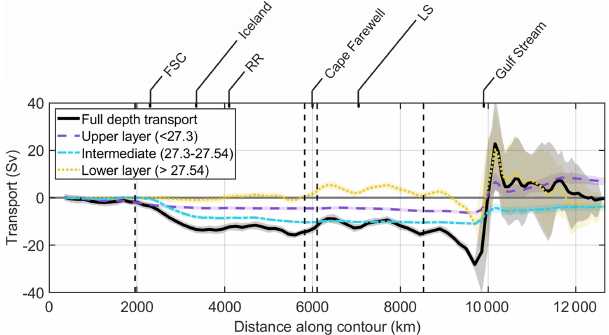
Figure 8. Cumulative volume transport into the SPG interior (geostrophic plus surface Ekman) between the surface and the seabed. Adjustment velocity is applied below 1000m to conserve volume. Transport in the upper, lower, and intermediate layers is also shown; these are defined in Sect. 3.4. Key locations around the boundary are labelled as in Fig. 3, and vertical dashed lines denote OSNAP